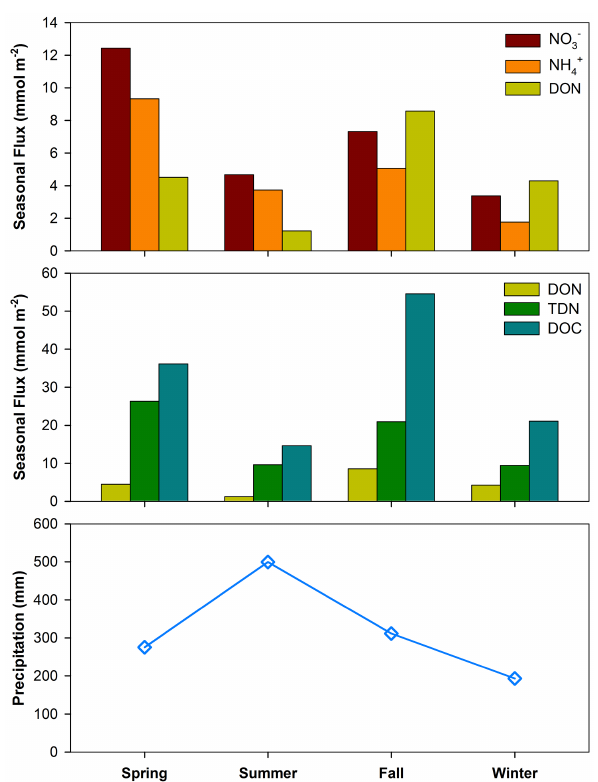
Figure 5. Seasonal wet depositional fluxes of NO − TDN, and DOC at Uljin. The precipitation amounts for each season are also shown.